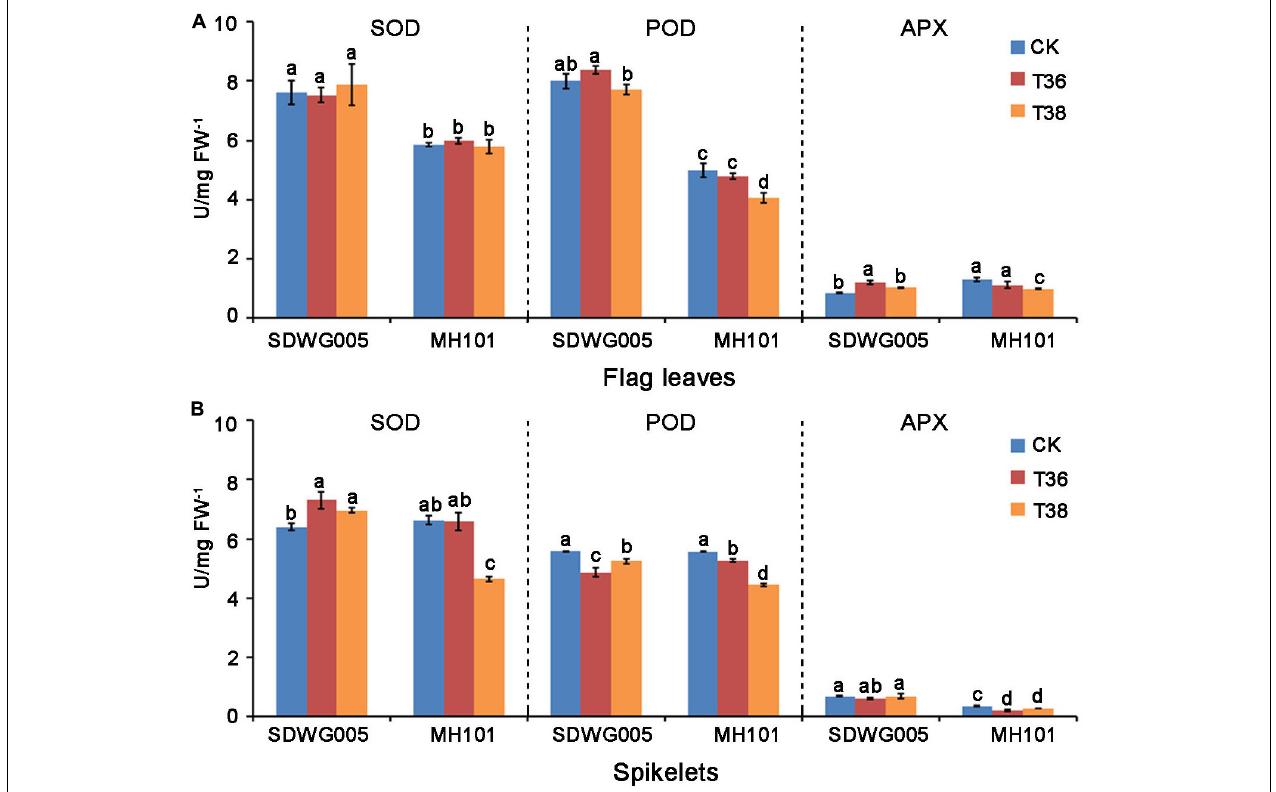
FIGURE 2 | SOD, POD, and APX activities in rice flag leaves and spikelets under different high-temperature stresses. (A) SOD, POD, and APX activities in rice flag leaves when exposed three days to different temperature treatments. (B) SOD, POD, and APX activities in rice spikelets when exposed three days to different temperature treatments. CK, T36 and T38 indicate normal temperature (about 28 ◦ C) and high temperatures T36 ( T max = 36 ◦ C) and T38 ( T max = 38 ◦ C). Each data point represents the mean ± SD of three biological replicates. Significant differences were calculated by One-way ANOVA with Duncan’s multiple test (SAS Institute, Inc., Cary, NC, United States). Different letters indicate the statistical difference between samples at P = 0.05.